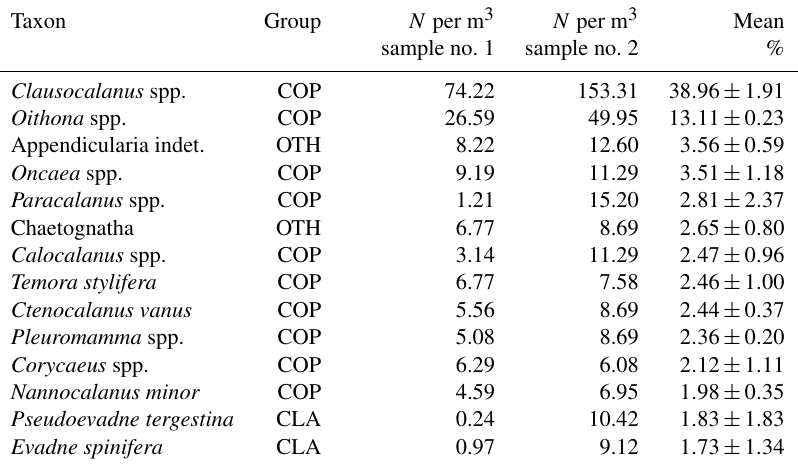
Table 2. Contribution of the most abundant species and/or taxa at the two sampling sites in number of individuals ( N ) per cubic metre of water (COP: copepods, CLA: cladocerans, OTH: other taxa). Taxon Group Clausocalanus